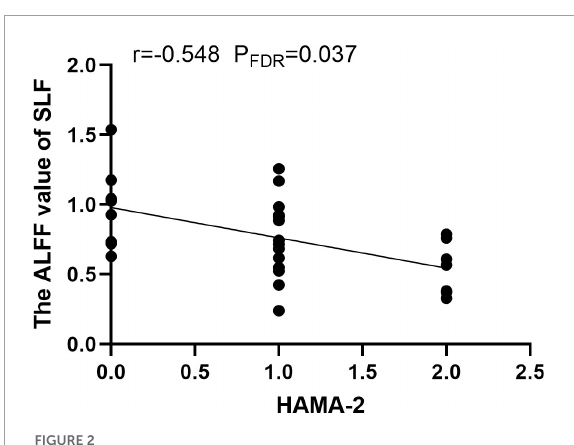
FIGURE2 The amplitude of low frequency fluctuation (ALFF) value of superior longitudinal fasciculus (SLF) was negatively correlated with the HAMA-2